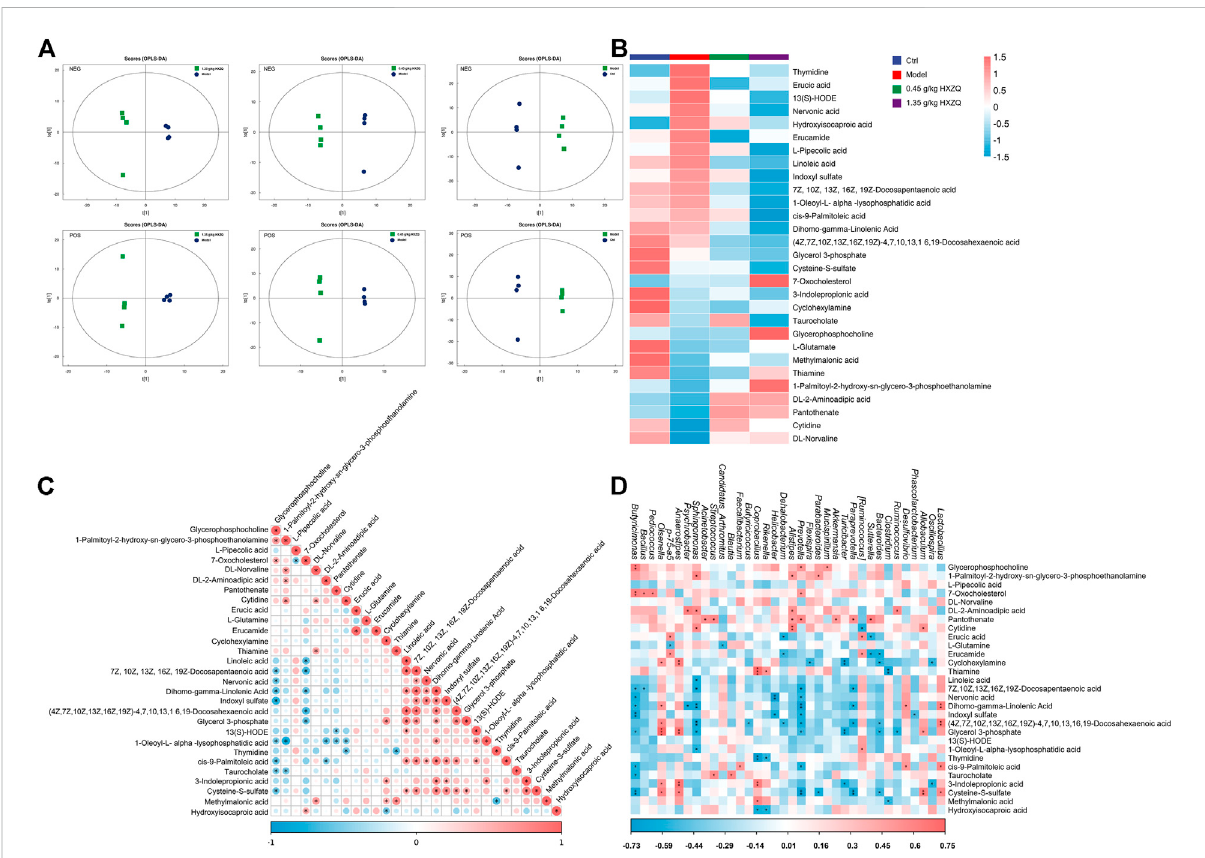
FIGURE 3 HXZQ regulated serum metabolite levels in AOM/DSS mice (A) OPLS-DA score plot. (B) Heatmap of 29 signi fi cantly altered metabolites in HXZQ-treated AOM/DSS mice. (C) The associated heatmap of altered metabolites. (D) The associated heatmap of signi fi cantly altered metabolites and microbiota